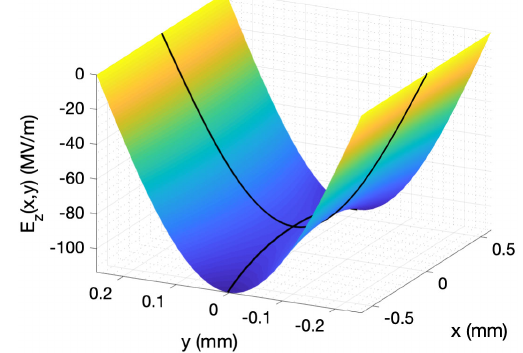
FIG. 19. A transverse central cross section of an accelerating in CST that is dominated by the quadrupole phase of E z component. The saddle point is denoted with intercepting axial lines.